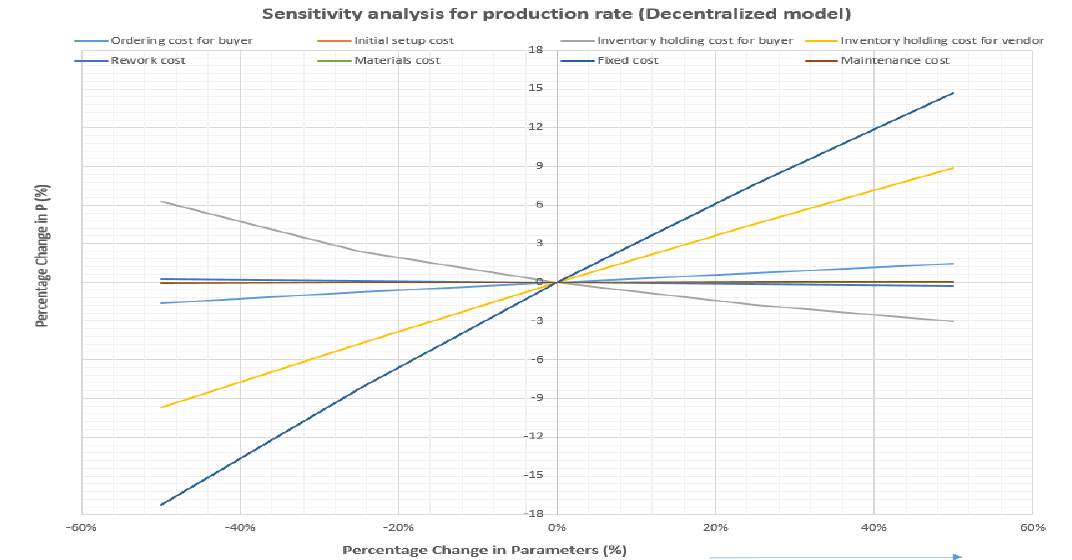
Figure 10. Sensitivity analysis: production rate (P) versus change in parameters under decentralized model.